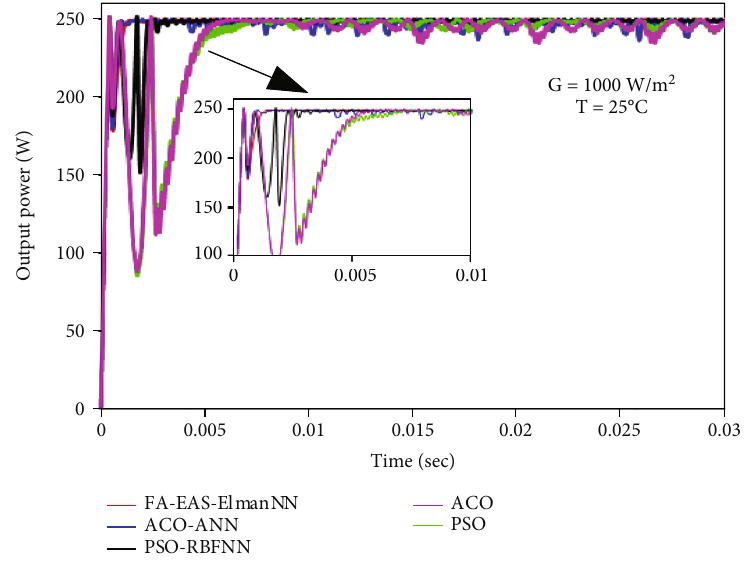
Figure 12: MPPT curve at startup.